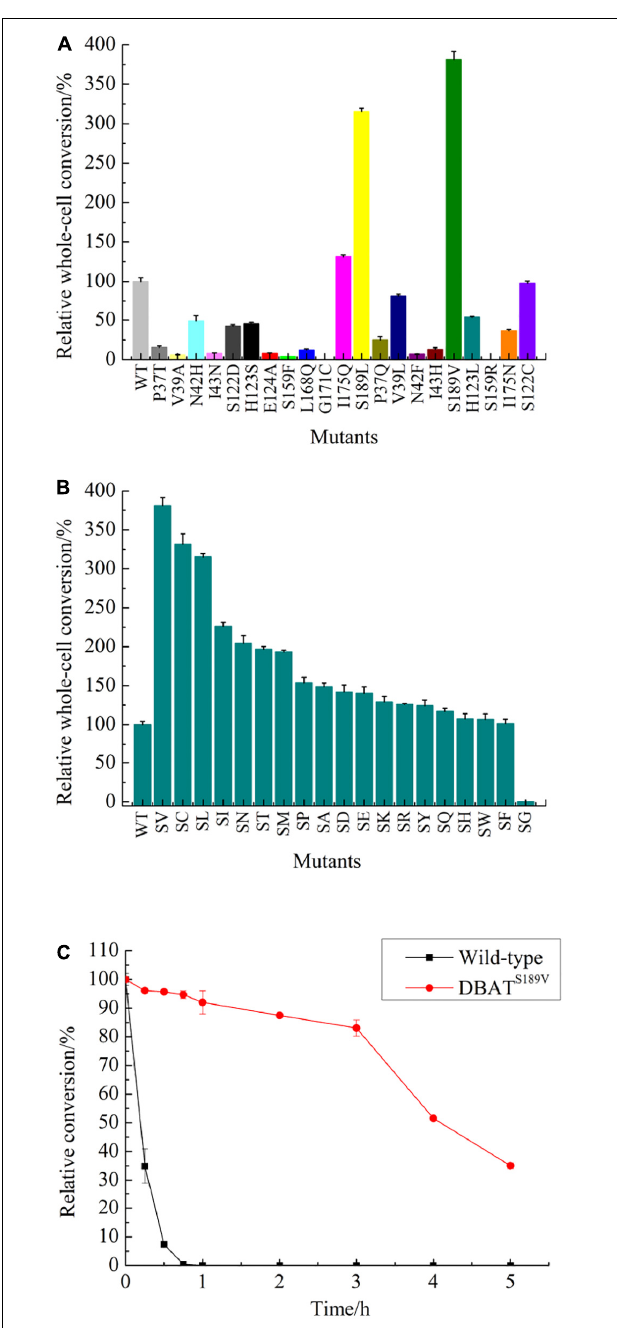
FIGURE 3 | Two rounds of mutation library screening results and thermal stability analysis results. (A) Screening results for the “hotspot” mutants by whole-cell bioconversion. (B) Screening results for site-saturated mutations by whole-cell bioconversion. (C) Thermal stability of the crude enzymes of DBAT S189V and